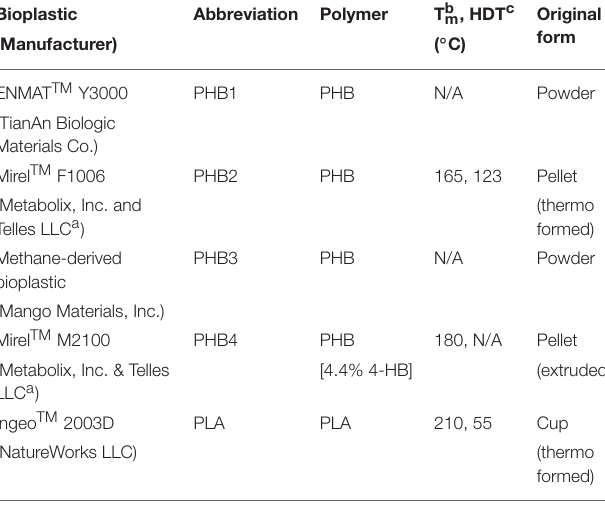
TABLE 1 | Summary of